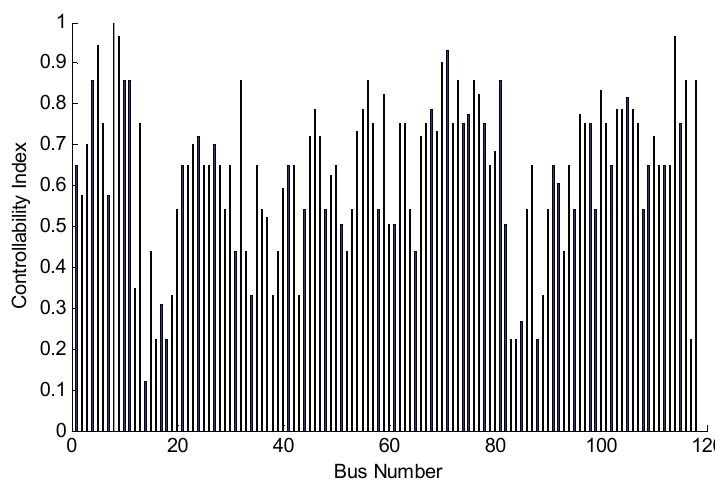
Figure 4. Normalized controllability